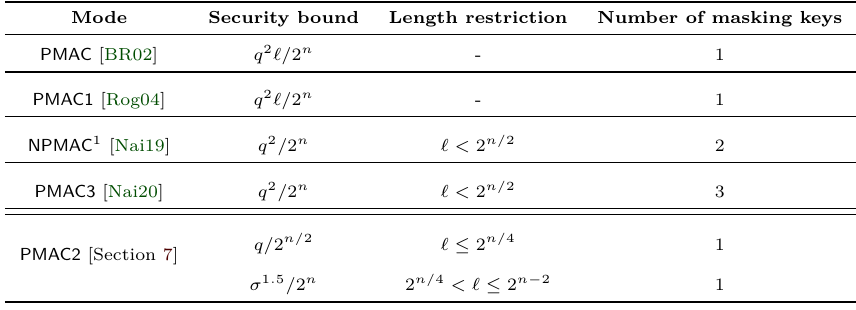
Table 1: A comparative summary of several PMAC variants. Here q denotes the number of queries, ‘ denotes the upper bound on query-length, and σ denotes the upper bound on total number of blocks present in all